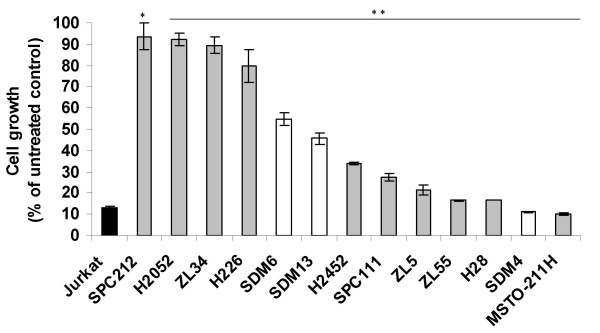
Activity of TRAIL in MPM cell lines or primary cultures. Jurkat T cell leukemic cells (black column), commercially available and/or well-established MPM cell lines (grey columns) and primary MPM cultures (white columns) were incubated with 100 ng/ml His-TRAIL, and cell proliferation was determined by MTT assay 72 h thereafter. Absorbance values obtained with untreated cells maintained under identical conditions were taken as 100%. Data represent means of three independent experiments and bars indicate standard deviations. **, P < 0.01 and *, P < 0.05 compared to untreated cells.